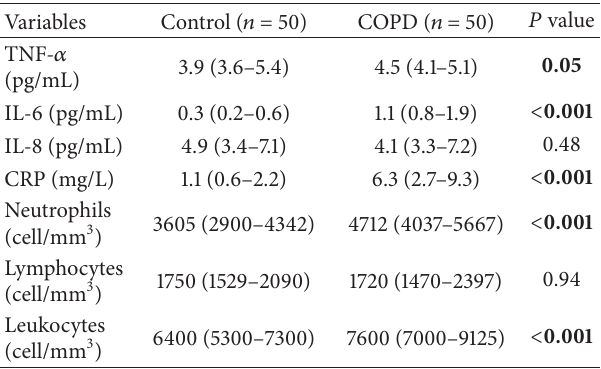
Table 2: Inflammatory markers in the serum of control subjects and COPD